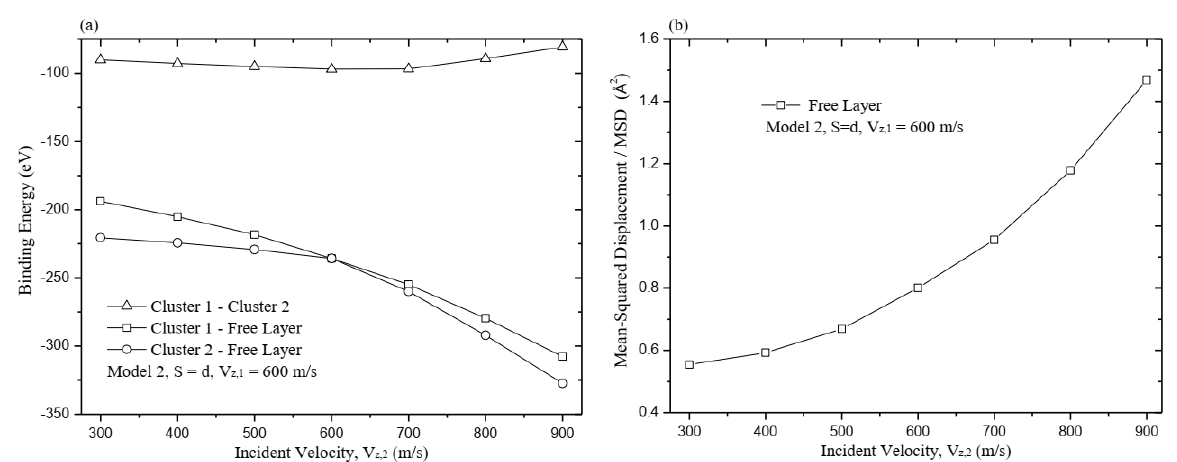
Figure 11. ( a ) Binding energy among Cluster 1, Cluster 2 and free layer at various V z ,2 . ( b ) MSD of free layer at various V z ,2 . In all cases, V z ,1 = 600 m/s and S = d.